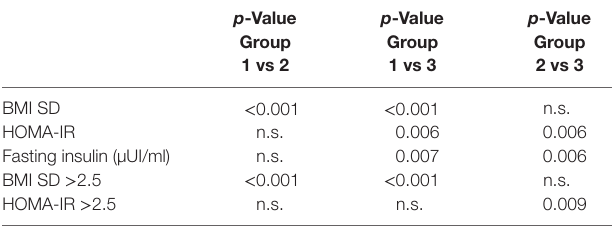
Table 5 | Pairwise comparisons among three groups according to age of patients.